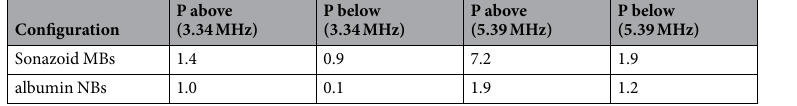
Table 1. Pressure parameters used in simulations from cavitation